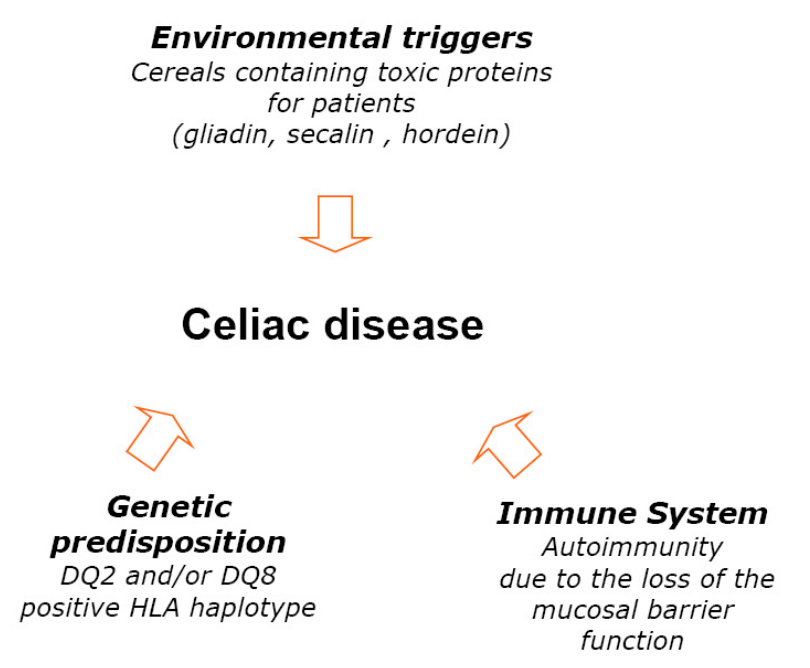
Figure 1. Factors involved the pathogenesis of celiac